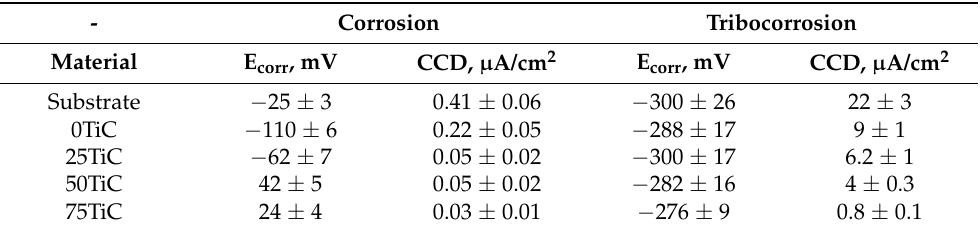
Table 2. The corrosion potential (E corr ) and corrosion current density (CCD) of coatings and steel substrate measured during potentiodynamic experiments in steady-state (corrosion) and under wear conditions (tribocorrosion). Corrosion